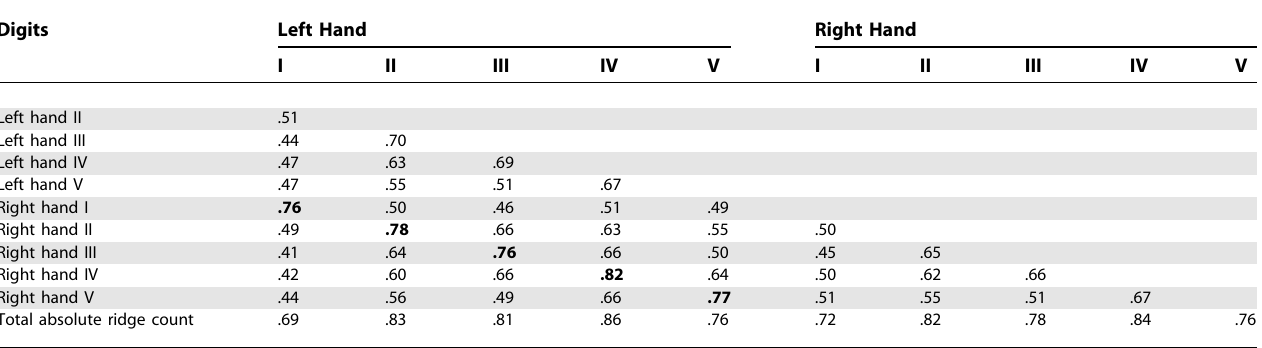
Table 4. Phenotypic Correlations between Absolute Ridge Count on Each Digit, Correlations between Homologous Digits in Bold Digits Left Hand